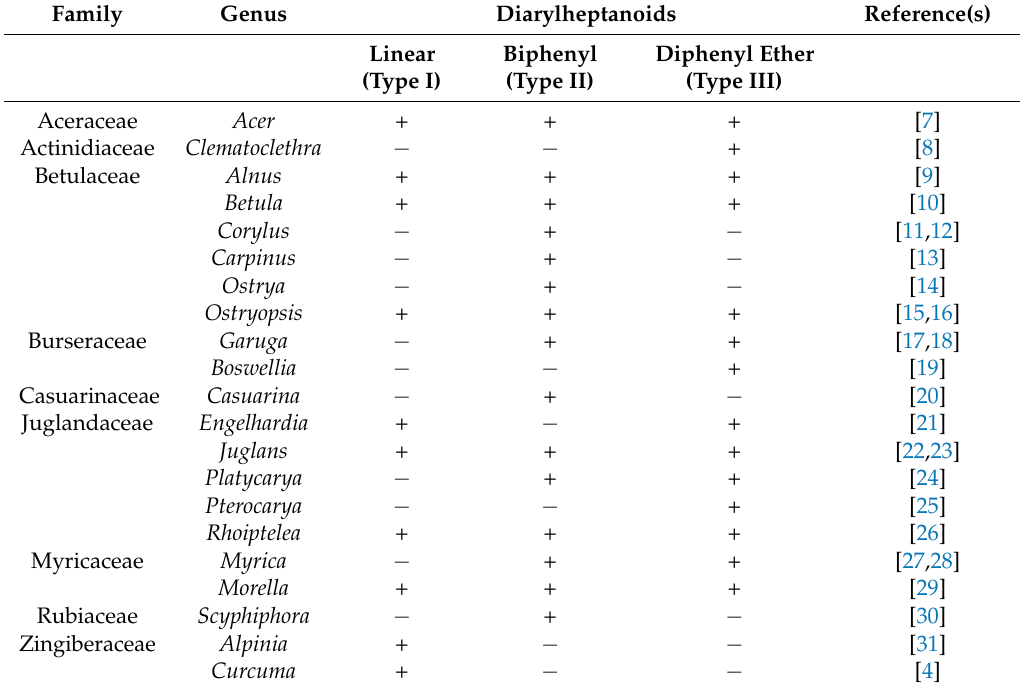
Table 1. Occurrence of diarylheptanoids in plants reported in the